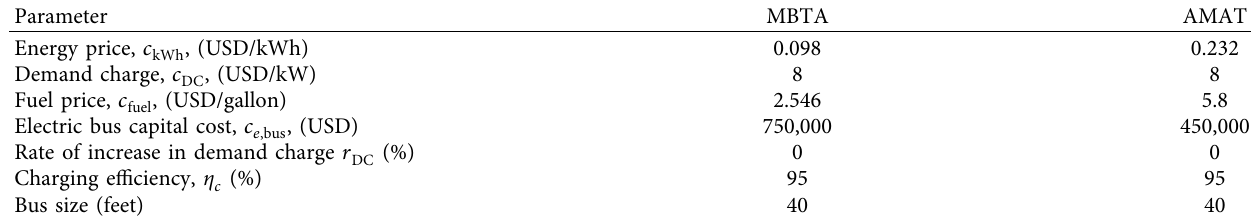
Figure 9: Energy efciency of 40-foot-long electric buses for AMAT. Table 2: Parameters used for the TCO estimation (user input to the tool).